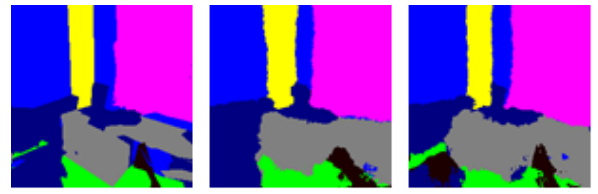
Figure 5. Improvement of the labeling at the boundaries using depth on example of class column (yellow). The images represent: ground truth (left), RGB based label prediction (middle), R d G d B d based label prediction